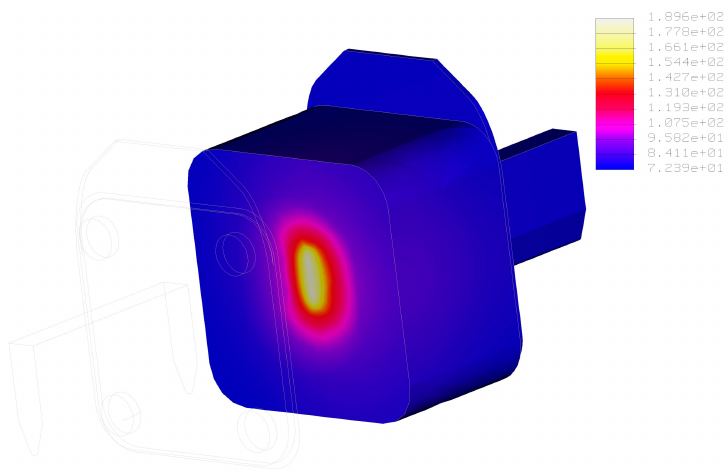
Figure 6. Temperature release through the fuse at 50%